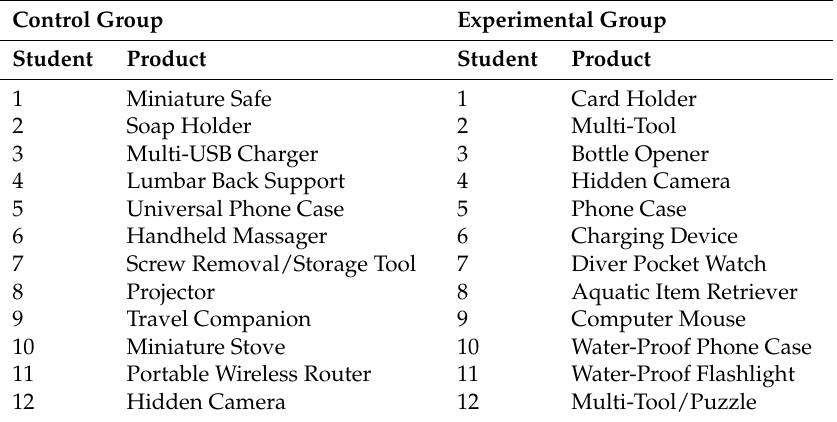
Table 4. “Terpee” Product